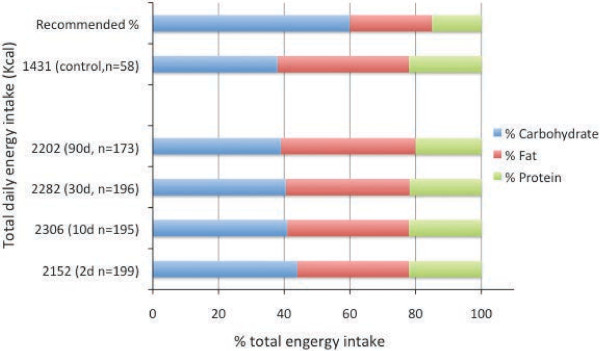
Daily energy intake distribution from carbohydrate, fat, and protein1.1The recommended distribution of daily energy intake in China is carbohydrates 55% ~ 65%, protein 12% ~ 16% and fat 20% ~ 30% respectively. The figure constructed using the media figure of the recommend levels of daily energy intake distribution from carbohydrates 60%, protein 15% and fat 25%.